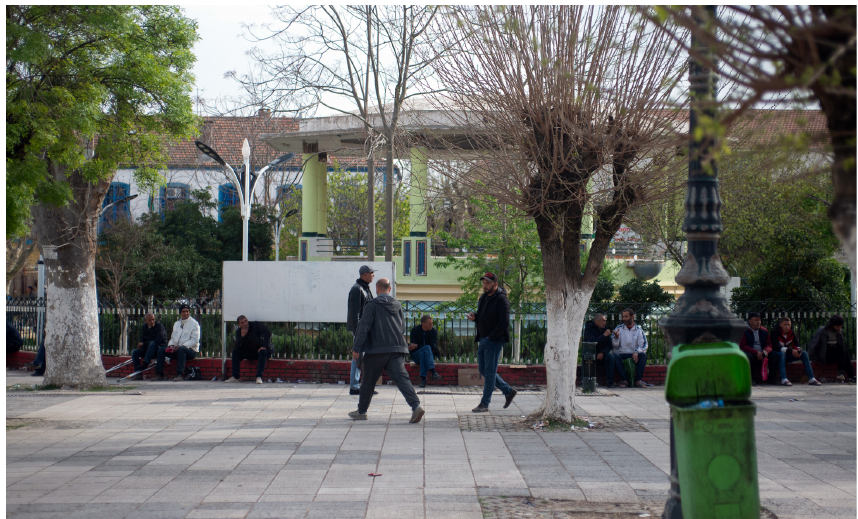
Fig. 6. November 1st 1954 Square of Medea. Public spaces, which are used as urban